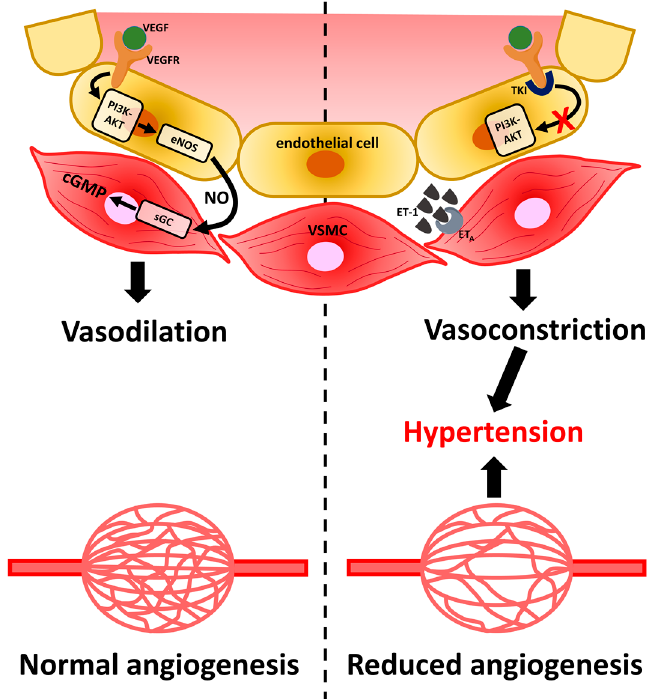
Figure 2. The effects of VEGF on blood pressure and capillary vascularization under: physiological conditions ( left ); and TKI therapy ( right ) (adapted from [39]). VEGF (vascular endothelial growth factor), VEGFR (vascular endothelial growth factor receptor), PI3K (phosphatidylinositol-3-kinase), AKT (protein kinase B), eNOS (endothelial nitric oxide synthase), sGC (soluble guanylyl cyclase), ET-1 (endothelin-1), ET A (endothelin receptor type A), NO (nitric oxide), cGMP (cyclic guanosine monophosphate).